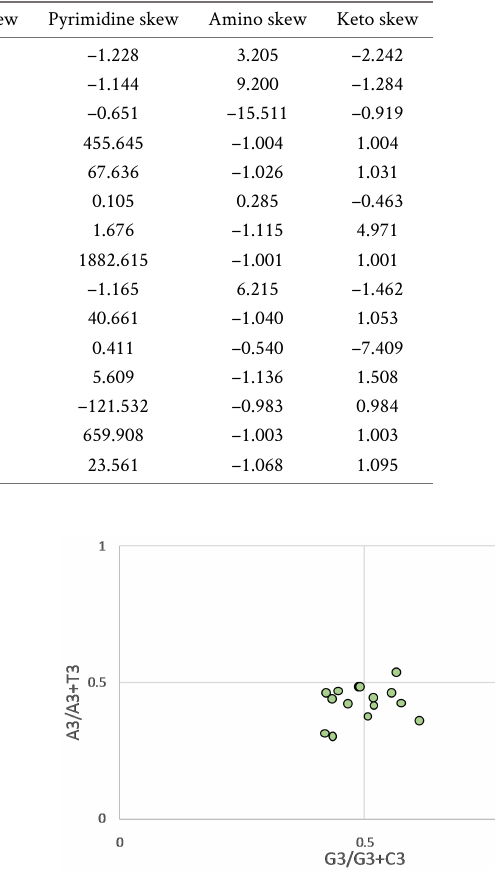
Table 2. The genes show the AT skew, GC skew, purine skew, pyrimidine skew, amino skew and keto skew.